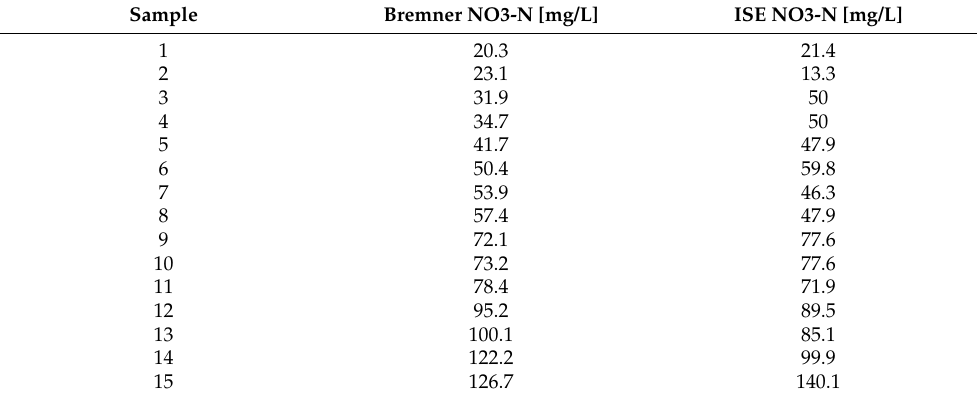
Table 1. Comparison between ISE probe nitrate-nitrogen measurement results and results obtained according to the Bremner